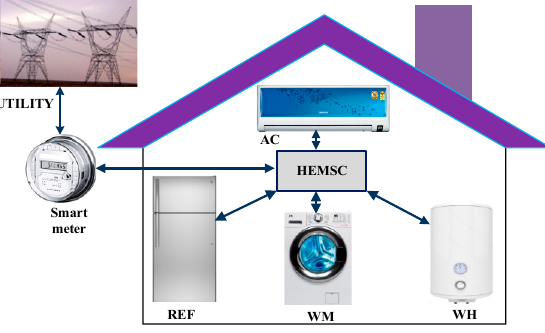
Figure 1. Block diagram of the proposed home energy management scheduling controller (HEMSC) system. AC: air conditioner; REF: refrigerator; WM: washing machine; WH: water